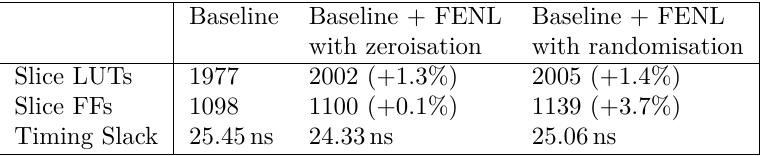
Table 2: A table, for each core, capturing some implementation results (including overhead vs. the baseline); timing slack is quoted wrt. a 25 MHz